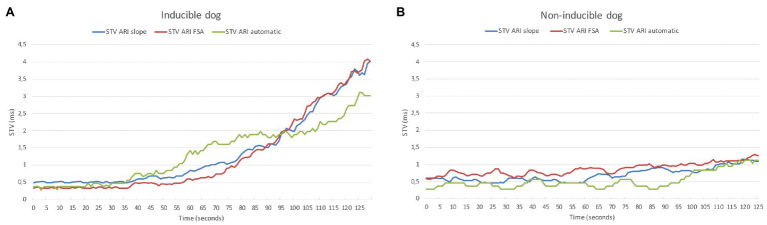
Example of STVARI in inducible (A) and non-inducible dog (B) after dofetilide. STVARI measured with the slope method (blue line), fiducial segment averaging (FSA) method (red line), and automatic method (green line) from the moment of dofetilide infusion at time = 0 s.